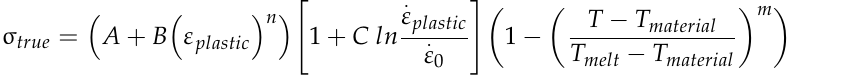
Figure 13. Geometry description of surimi gel during numerical analysis ( a ), and mesh model ( b ).